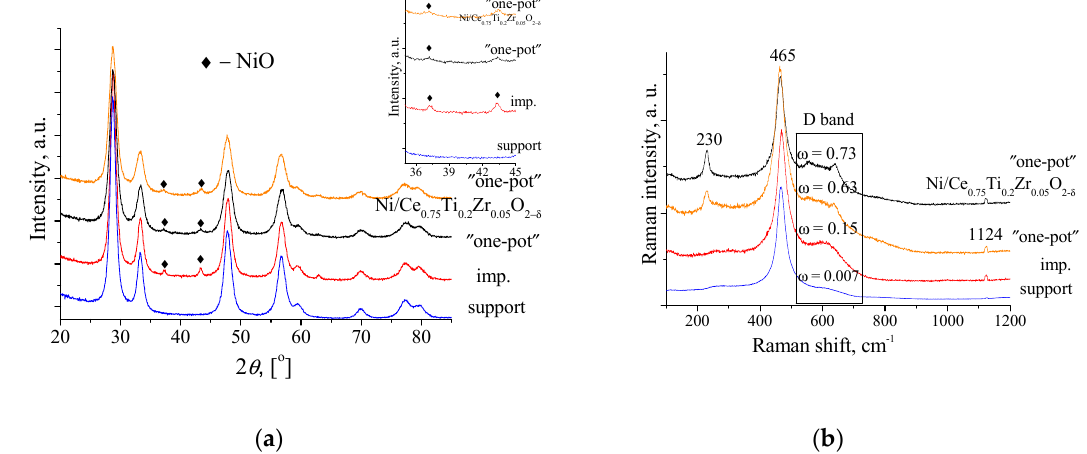
Figure 4. XRD patterns ( a ) and Raman spectra ( b ) of Ni / Ce 0.75 Ti 0.1 Zr 0.15 O 2 − δ one-pot catalysts prepared in supercritical conditions and calcined at 700 °C.